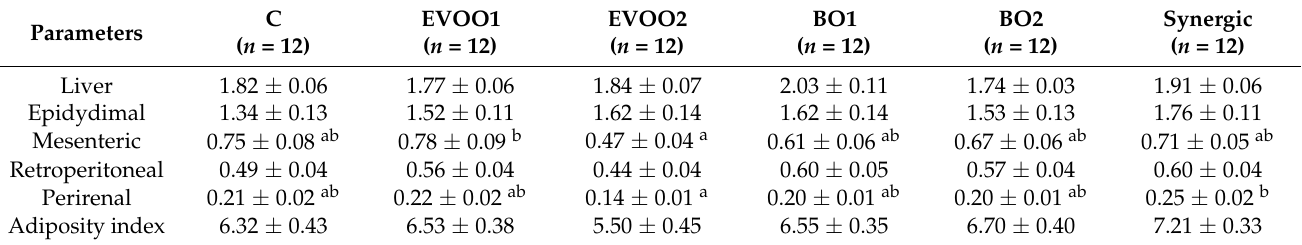
Table 7. Weights (g) of liver and visceral fats (g), and adiposity index